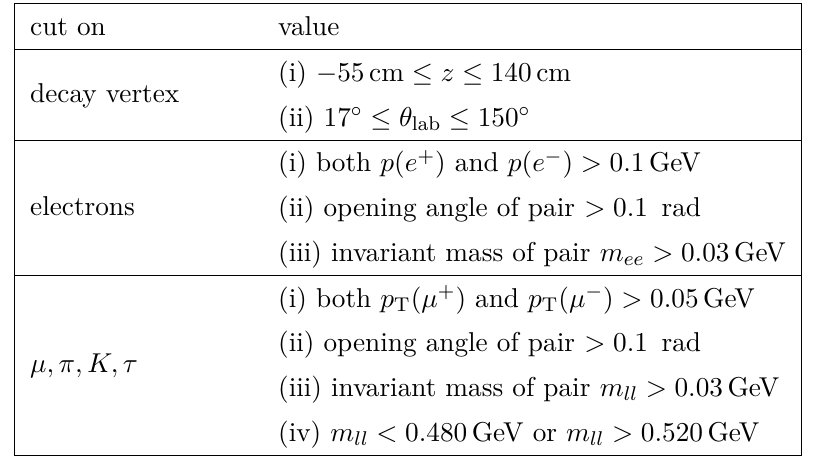
Table 4 . Kinematic selections used in our